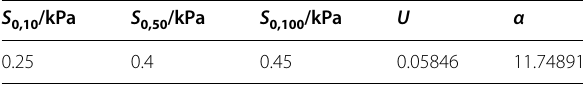
Nominal live load (office or residential) Table 6 Some reference snow pressure and probability distribution parameters for